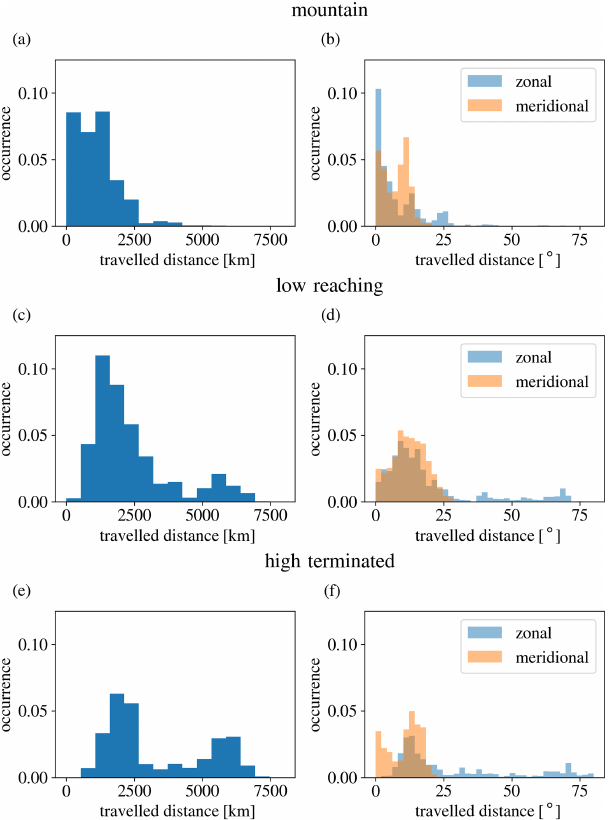
Figure 5. Distribution of the distance between the launch point (25km altitude) and termination point below. Distances are weighted by relative GWMF at ray launch; hence, rays associated with more momentum flux in the stratosphere are emphasised. The left column shows geometric distances along a great circle; the right column shows distances in zonal and meridional